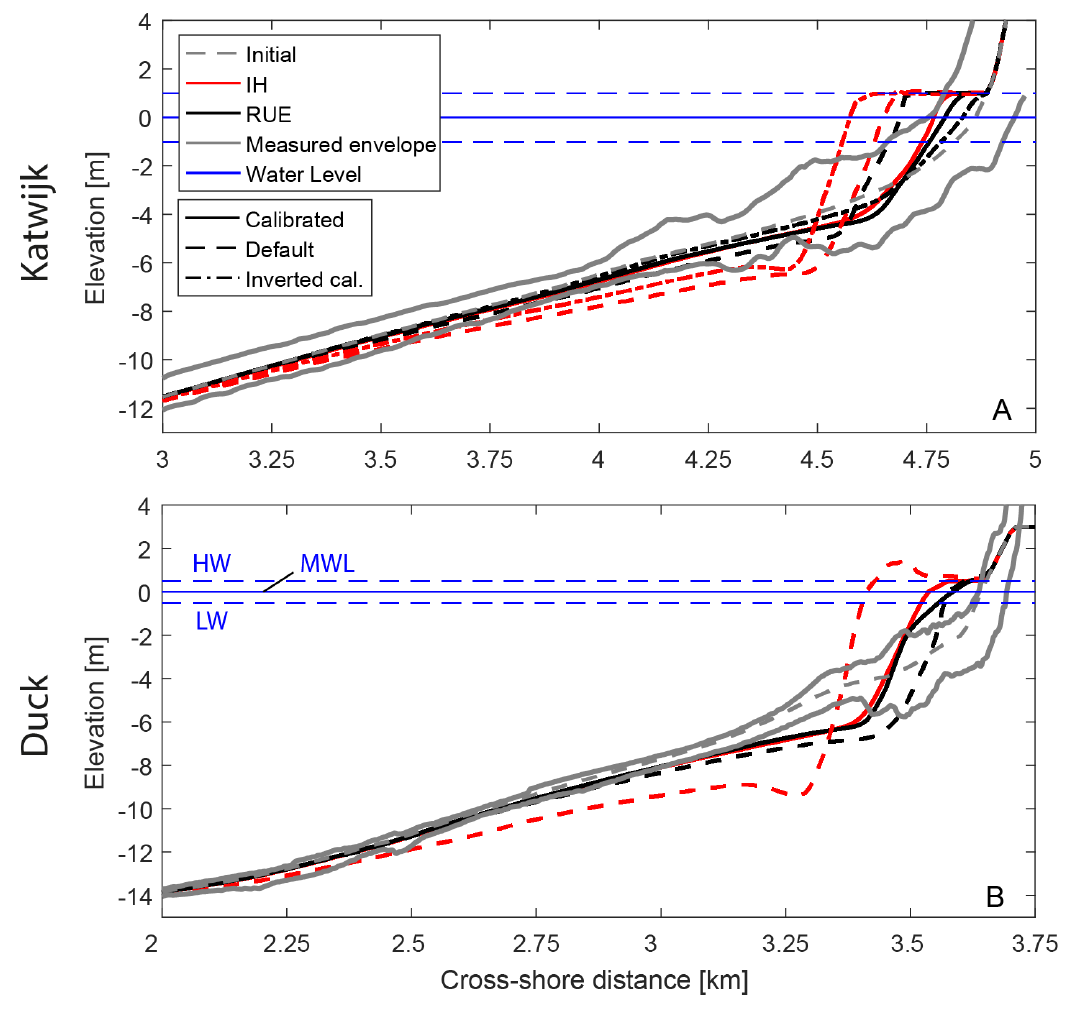
Figure 8. Cross-shore bed profiles at ( A ) Katwijk and ( B ) Duck after 10 morphological years. Katwijk ( A ) contains default, calibrated and inverted-calibration scenarios while Duck ( B ) default and calibrated. Initial and measured envelope are shown in gray, and water levels in blue. IH and RUE are color-coded with red and